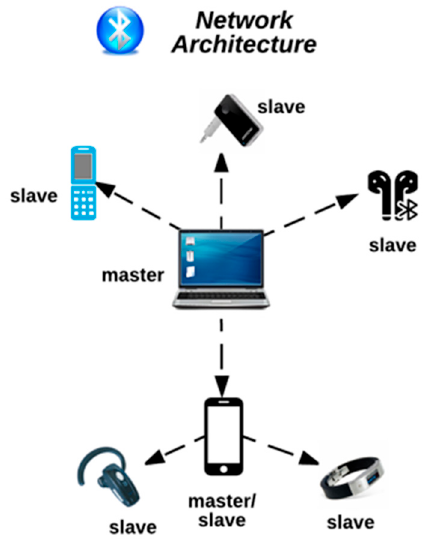
Figure 1. Bluetooth Piconet.